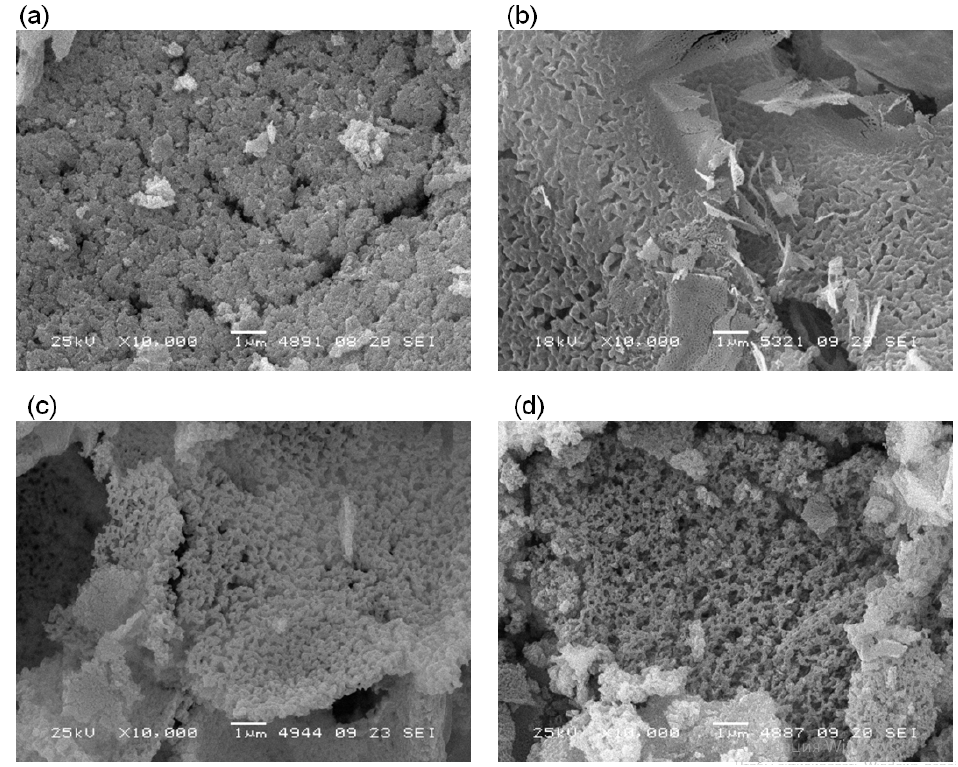
Figure 16. SEM images of (CeM) 0.8 Ni 0.2 O y samples after activation: without M ( a ), M = Al ( b ), La ( c ), and Mg ( d ). ( b – d )—M/Ce molar ratio is equal to 1.